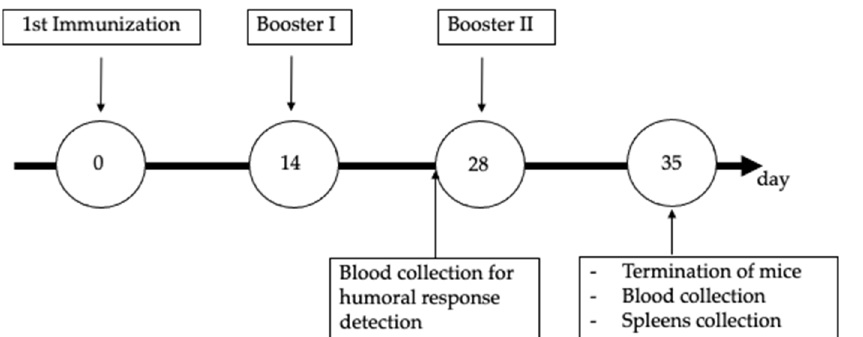
Figure A1. Immunization scheme of pCDNA3.1- lipX for the mouse immunization group as well as the blood collection, termination, and spleen collection for all groups.